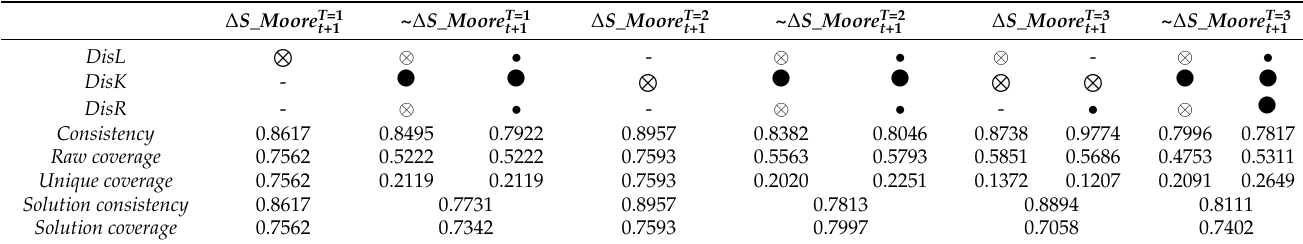
Table 5. Configuration of Factors Influencing the Change Degree of Marine Fishery Industrial